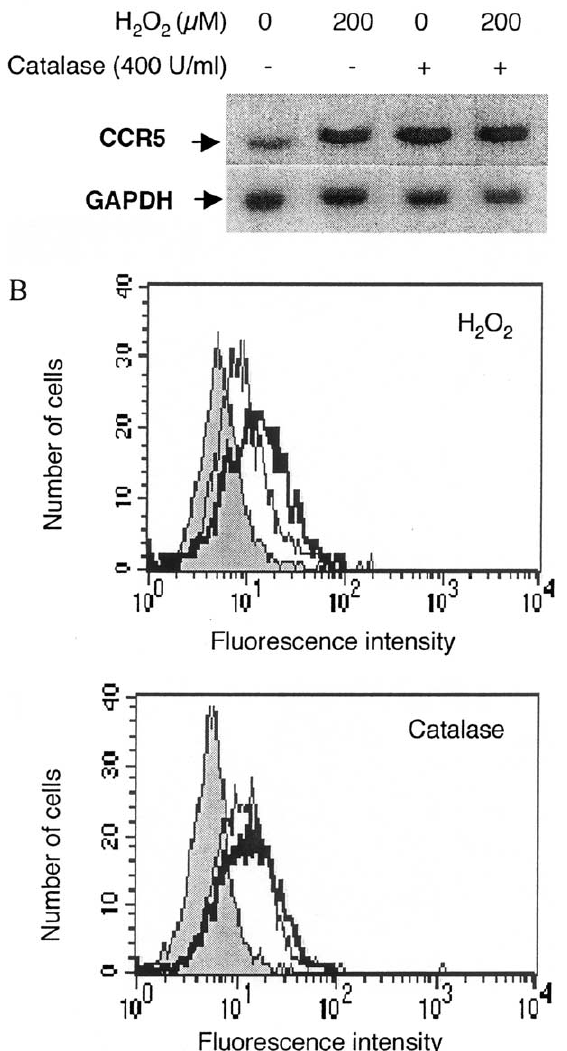
FIG. 7. Effect of catalase on CCR5 expression. (A) Monocytes were treated with 200 m M of H 2 O 2 in the absence or presence of catalase (400 U/ml) for 4 h in serum-free medium and total RNA was extracted and analysed by northern blotting for CCR5 mRNA expression. Autoradiogram of one representa- tive experiment. (B) Monocytes were treated with 200 m M of H 2 O 2 in the absence or presence of catalase (400 U/ml) for 4 h in serum-free medium. The medium was then replaced